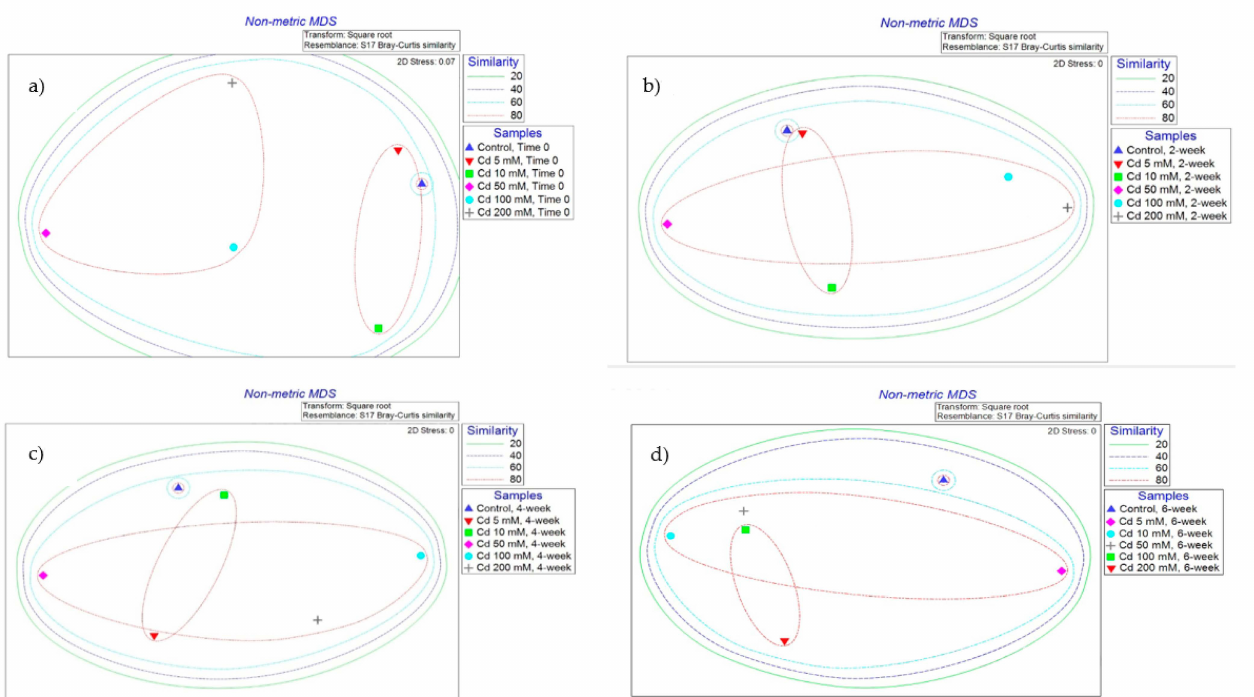
Figure 5. NMDS analysis plot of TRFLP relative peak height for Cd-spiked microcosms bacterial communities’ data, using the Bray–Curtis similarity indices. ( a ) Time zero, ( b ) 2-week incubation at 25 C ( c ) 4-week incubation at 25 C ( d ) 6-week incubation at 25 C. Significant difference ( p < 0.05) between the clusters specified with >60% of similarity compared to the control